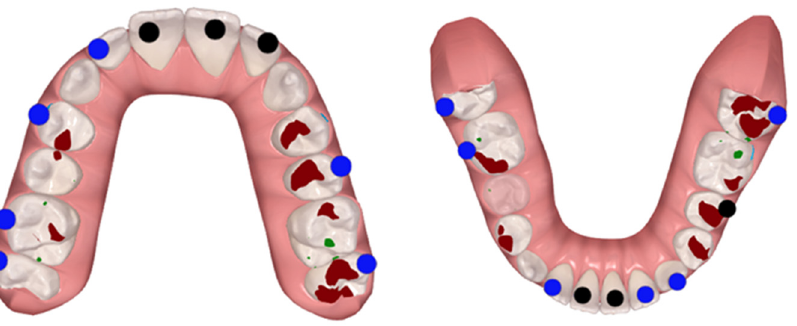
Figure 4. Initial ClinCheck ® . ( A ) beginning; ( B ) planned. Blue dots—moderate movements; black dots—complex movements.